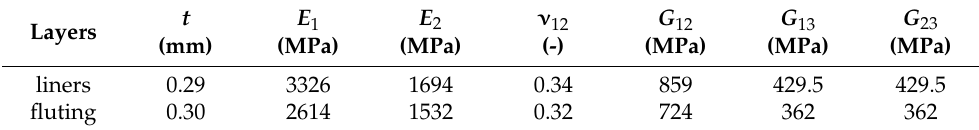
Table 1. Thicknesses and material properties of liners and fluting used in this study.